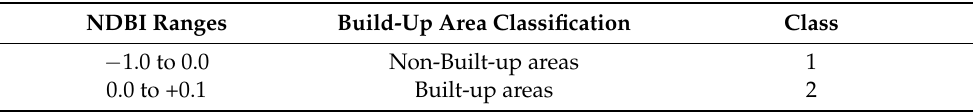
Table 4. NDBI ranges for Build-up Area Classification.